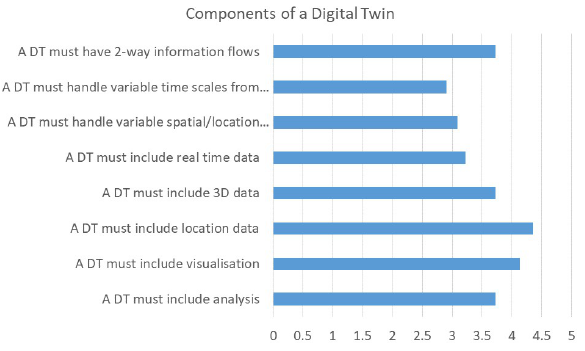
Figure 5: Importance of Digital Twin